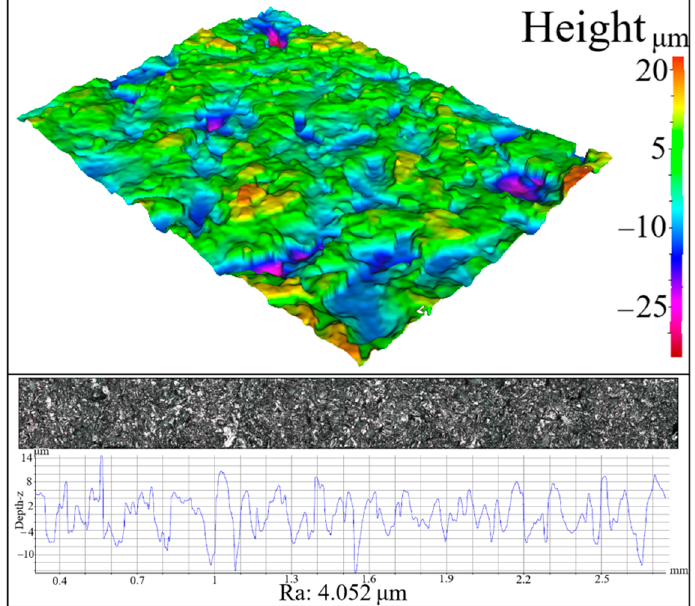
Figure 2. Three-dimensional morphology and a graphical study of the Ra parameter of the matrix after